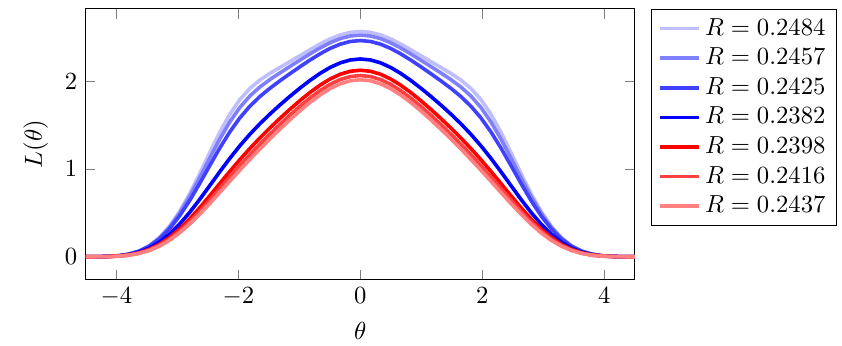
Figure 9. L ( θ ) for the 2CDD bosonic model of type (d) with θ 0 = 5 and γ = 3 π/ 10 , in which case R 0 . 2382 . Similarly to the fermionic case the function L ( θ ) for the secondary branch is ∗ ≈ everywhere greater than the one for the first